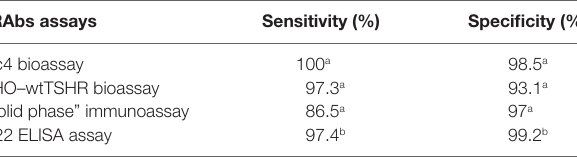
TABLe 3 | Comparison among sensitivity and specificity of the main TRAbs assays.